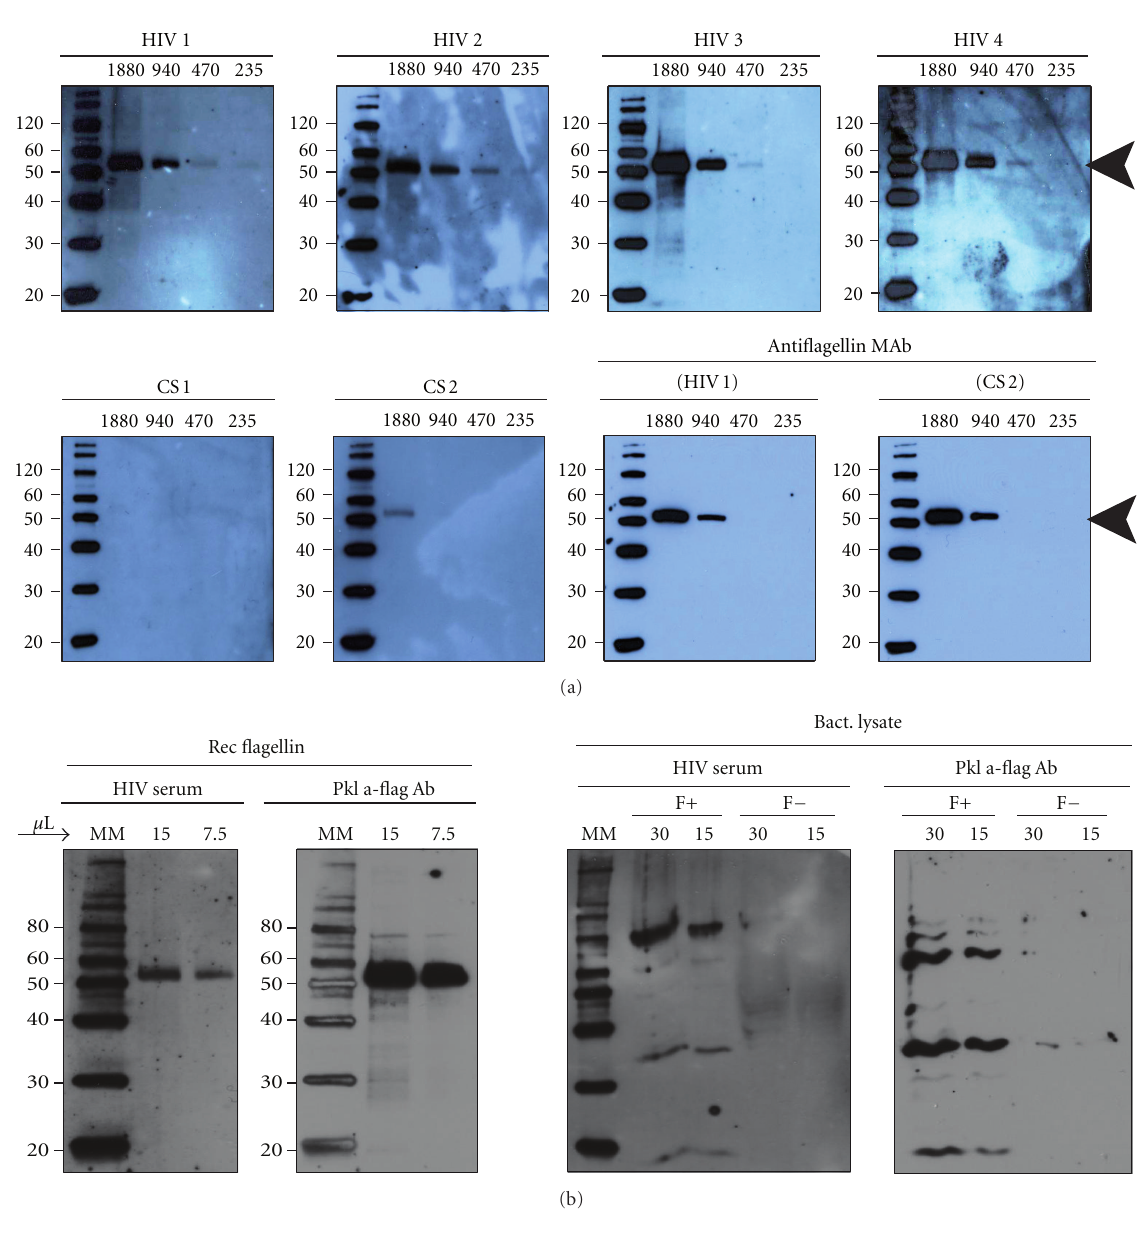
Figure 4: HIV-1-infected patients exhibit elevated levels of flagellin-specific antibodies. (a) Approximately 1.8 μ g of recombinant flagellin was twofold serially diluted (4 series) and resolved on 10–20% SDS-PAGE gel, transferred onto a nitrocellulose membrane, and detected with immunoblot assay. Serum from HIV-1-infected or control subjects diluted 1:1000 was used as a primary antibody. Each panel is a separate immunoblot of the same recombinant flagellin detected with serum from HIV-1 patients (HIV 1, HIV 2, HIV 3, HIV 4) or control subjects (CS 1, CS 2). To confirm equal sample loading and protein transfer, immunoblotted membranes from HIV 1 and CS 2 were stripped o ff and reprobed with monoclonal antibody directed against flagellin (blots in the lower panel). The experiments were performed using sera from ten HIV-1-infected patients and four control subjects. These presented data are representative for all immunoblots. The position of recombinant flagellin protein is indicated with an arrow to the right. Numbers to the left depict positions of molecular mass markers (in kDa). (b) Recombinant flagellin (column 1) and lysates of flagellated or aflagellate E. coli (columns 3 and 4) were subjected to SDS-PAGE and immunoblotted using serum from HIV infected patient (column 1 and 3, diluted 1: 1000) as primary antibody or polyclonal anti-flagellin antibody (columns 2 and 4, diluted 1: 1000). The membrane in column 1 was stripped o ff and reprobed with polyclonal anti- flagellin antibody (column 2). The numbers above the figures indicate the amount of sample loaded in each well (in μ L). MM, magic marker (Invitrogen); F+: flagellated; F − : aflagellate whole bacterial lysate; Pkl: polyclonal; Ab: antibody. Numbers to the left depict positions of molecular mass markers (in